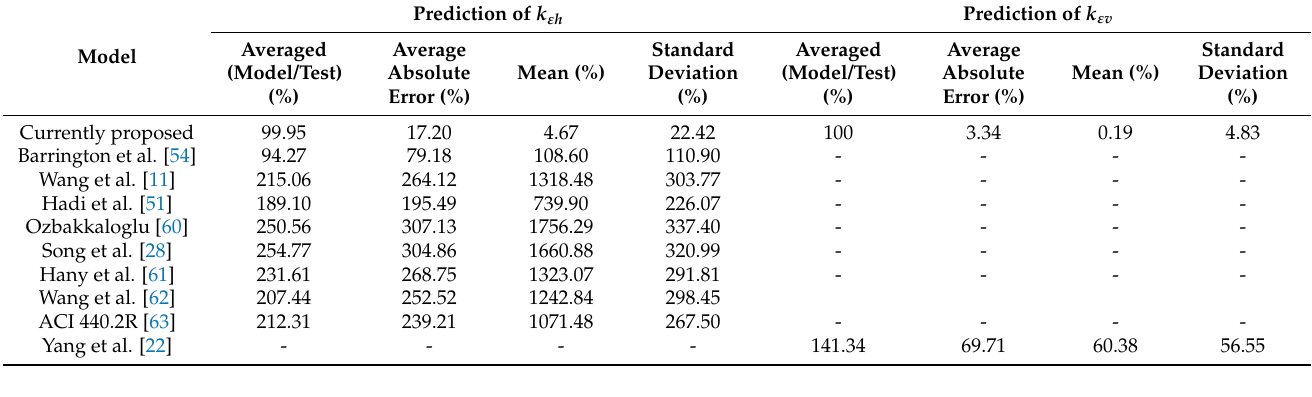
Table 5. Model predictions of FRP strain efficiency factor ( k ε h , k ε v ) of FRP-confined concrete.